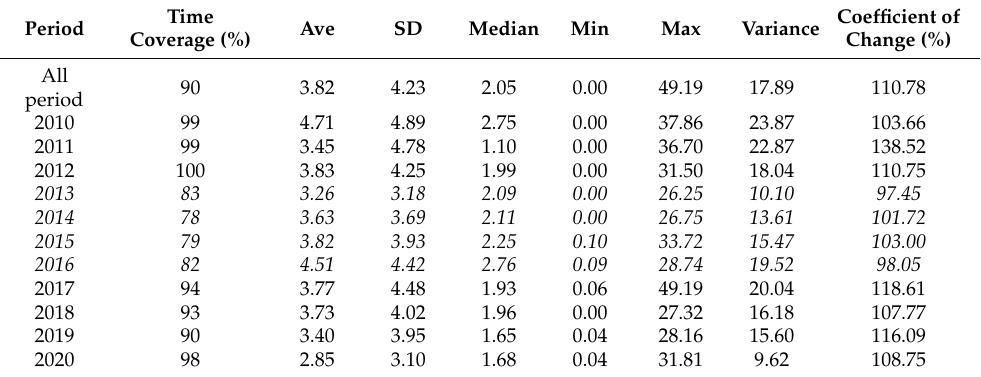
Table 1. Descriptive statistics of the series of measurements of eBC concentrations ( µ g · m − 3 ) over the entire measurement period and in individual